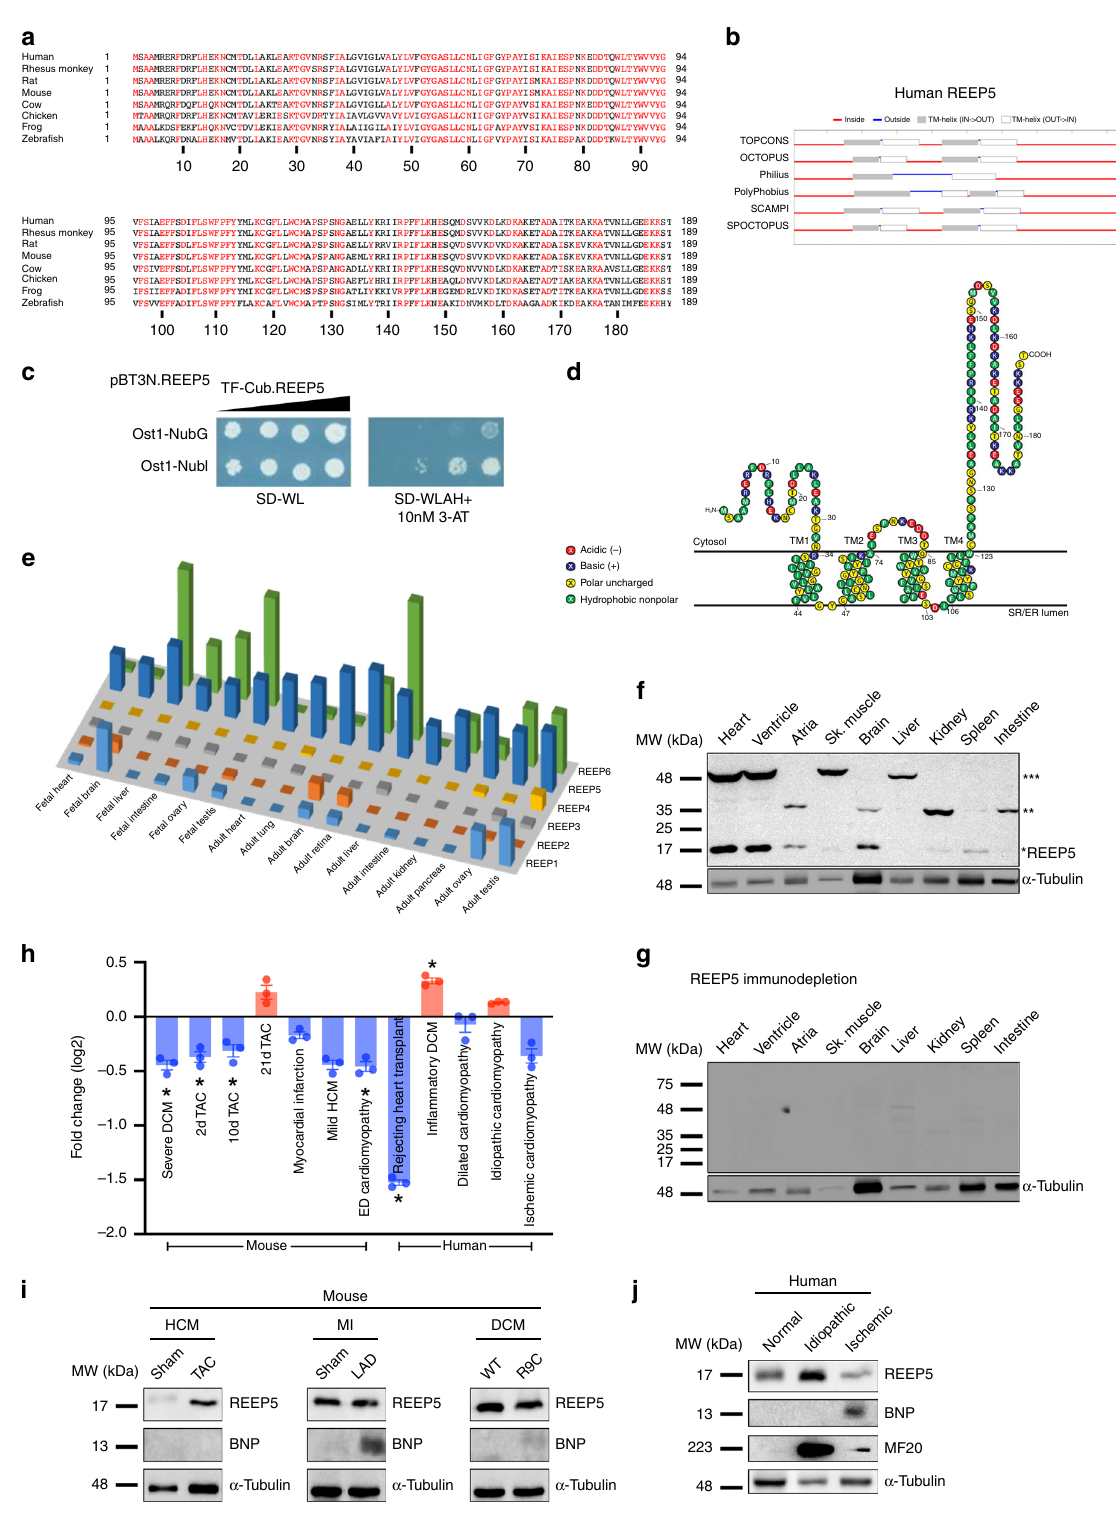
Next, we performed immunoblots using mouse cardiac tissue from a phospholamban (PLN) R9C DCM model 32 , 4-week post TAC heart failure model 33 , and 2-week post LAD ligation MI model 34 . A marked increase in REEP5 levels was seen in the 4- week TAC mouse hearts whereas REEP5 protein levels were decreased in the LAD ligation MI model (Fig. 1i).